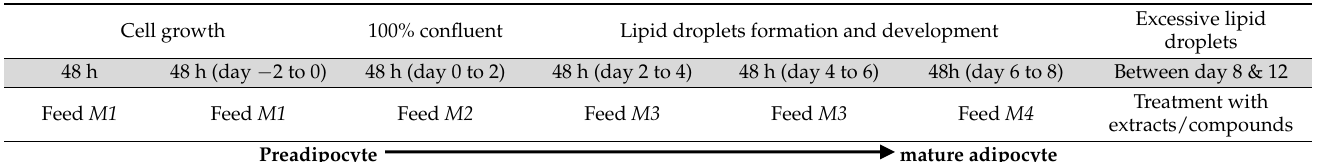
Table 8. Schematic workflow diagram of the cell differentiation.